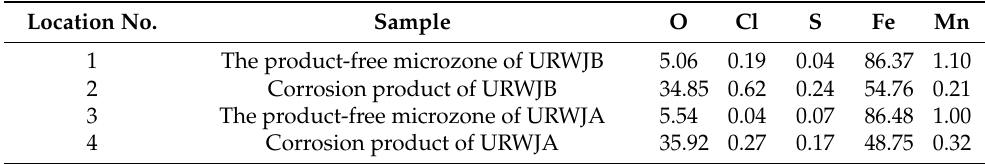
Table 6. Element content from EDS test corresponding to URWJs by FBW (wt. %). Location No.